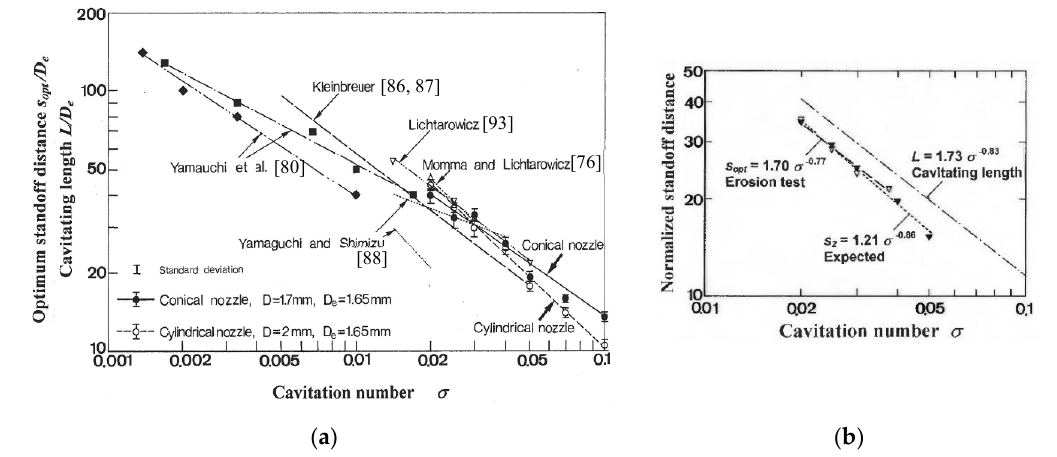
Figure 15. Relation between cavitation number and optimum standoff distance; ( a ) experimental result of optimum standoff distance and cavitating length; ( b ) estimated standoff distance from local cavitation number [72].